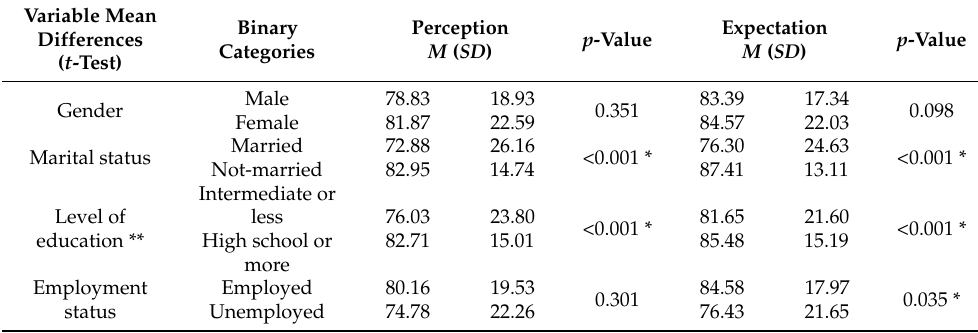
Table 2. Mean differences between perception, expectations, and some demographics.